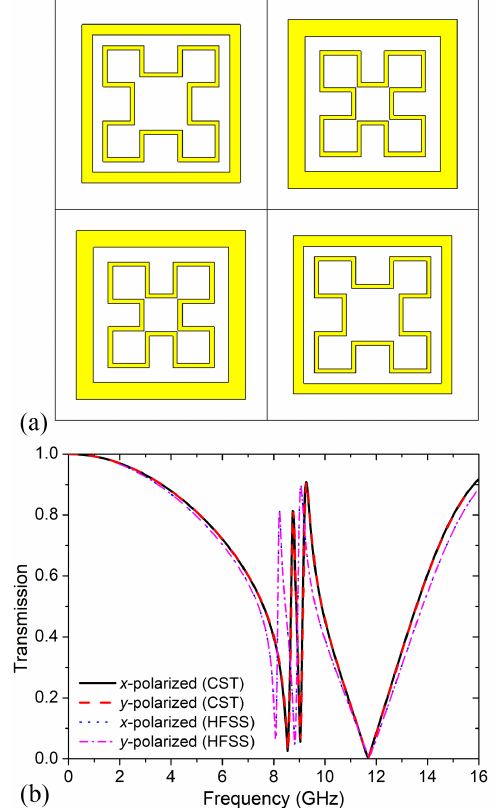
Figure 3: (a) Unit cell and (b) transmission spectra of the proposed dual-band polarization independent EIT-like metamaterial.